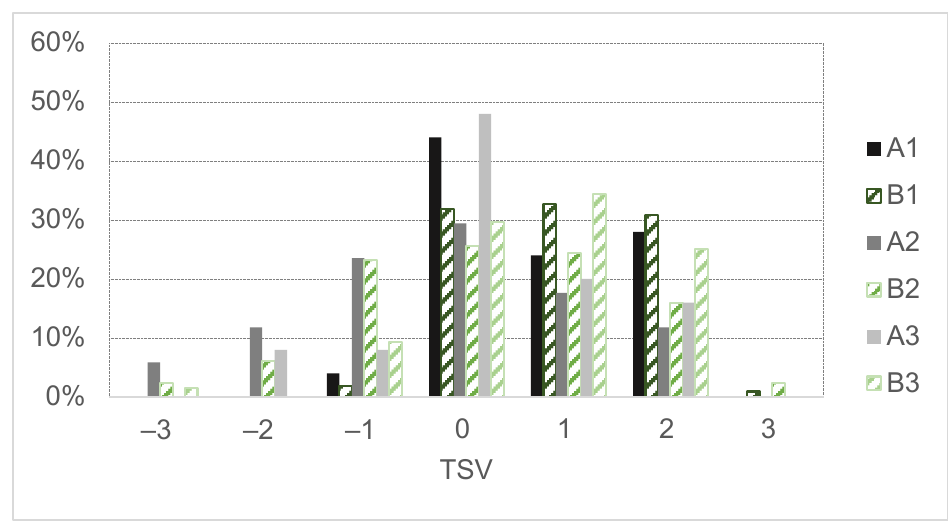
Figure 5. Relative frequency of TSV for both groups (A and B)—three survey days. Figure 6 shows the distribution of thermal preference votes (TPV). For the first and third measurement days, the TPV are centred on 0 (no change) and –1 (slightly cooler) and ‘no change’ and ‘slightly warmer’ during the second measurement day. Overall, during the whole survey period, the students evaluated their thermal environment mainly as warm, and their thermal preference was slightly cooler.